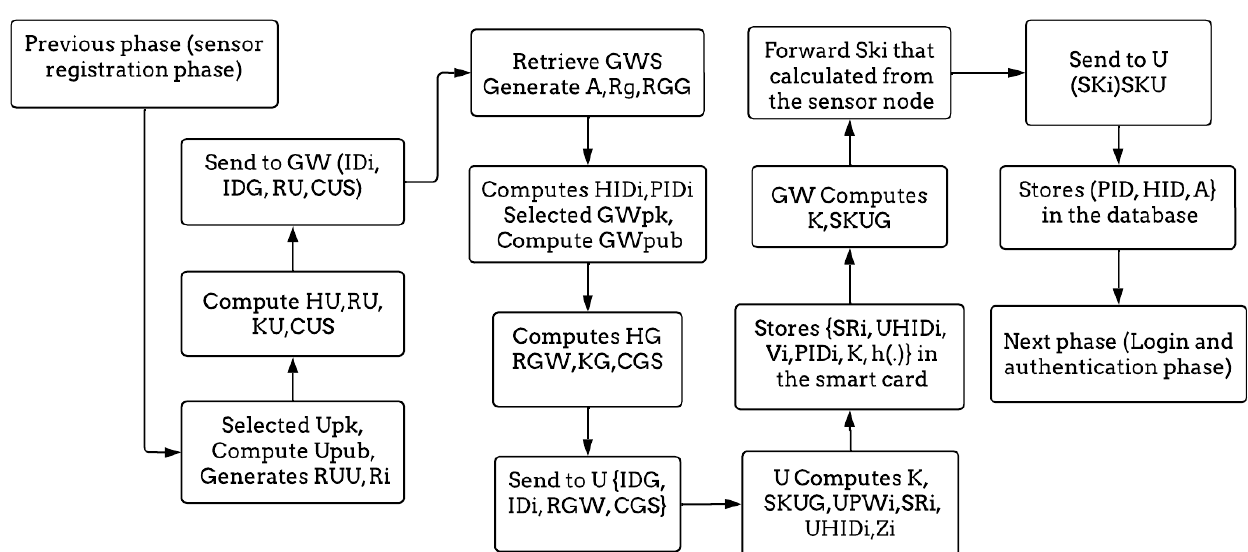
Table 4. User registration phase.